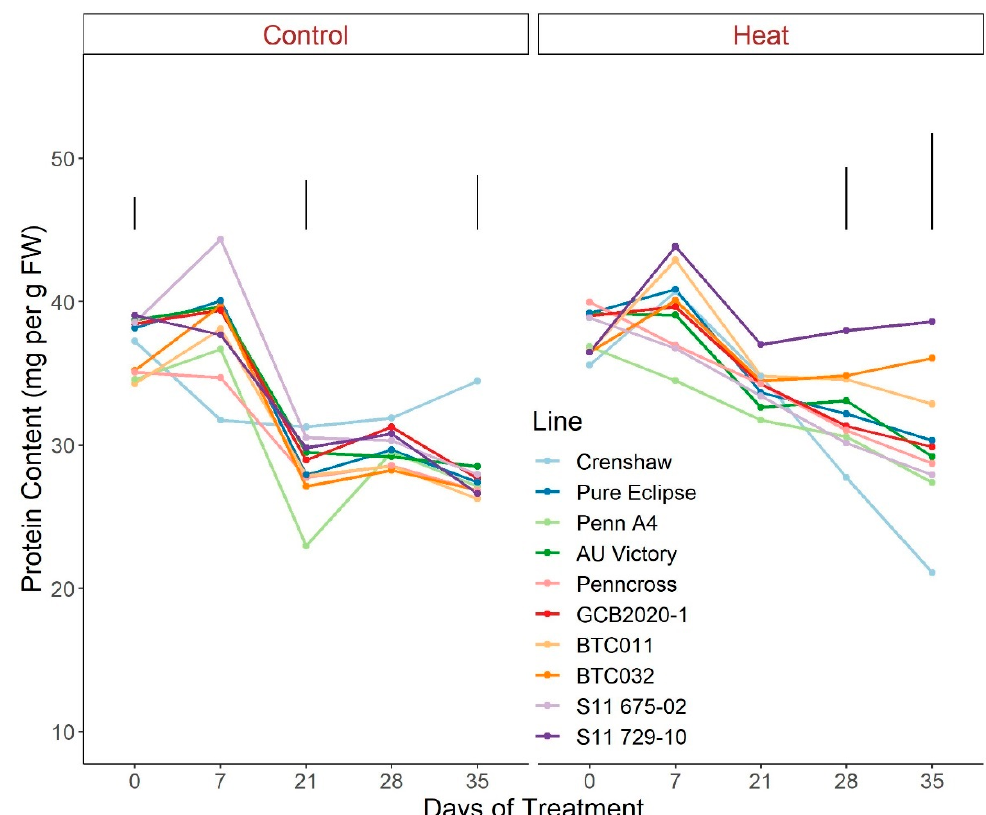
Figure 12. Change in total protein content for creeping bentgrass lines over time under control (20/15 °C day/night) and heat stress (38/33 °C day/night) conditions. Bars represent LSD values at p = 0.05 on days when significant differences among lines were found.